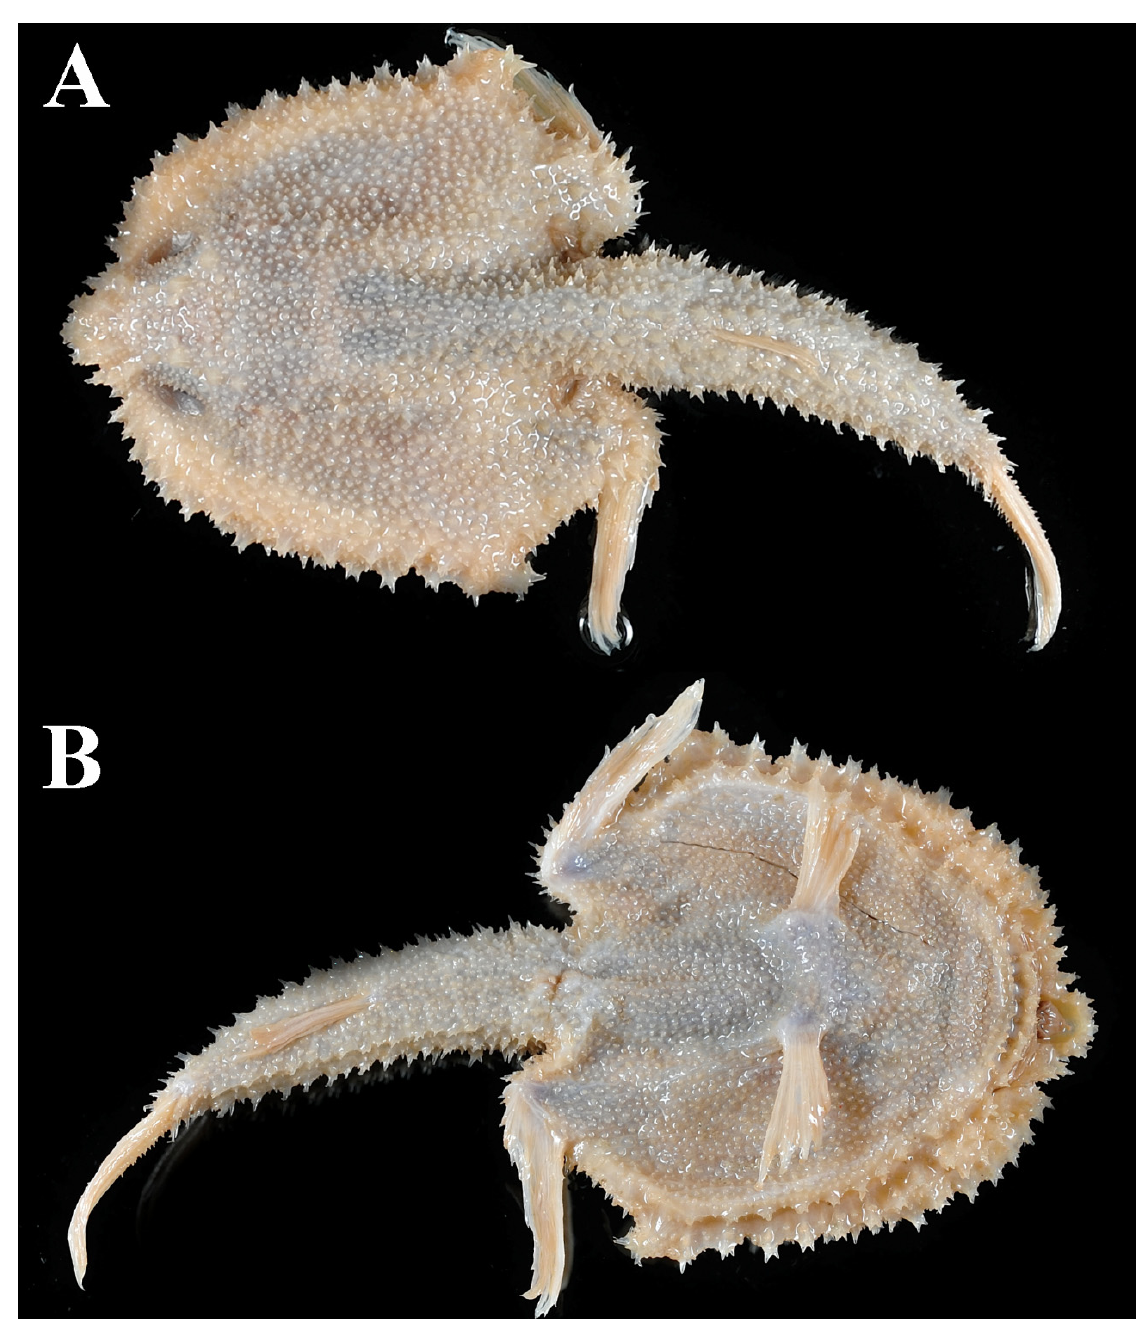
Figure 16. Halieutopsis margaretae Ho & Shao, 2007, NSMT-P18963, nontype, 64.9 mm SL, Japan, photos courtesy of NSMT. ( A ) Dorsal view. ( B ) Ventral view.